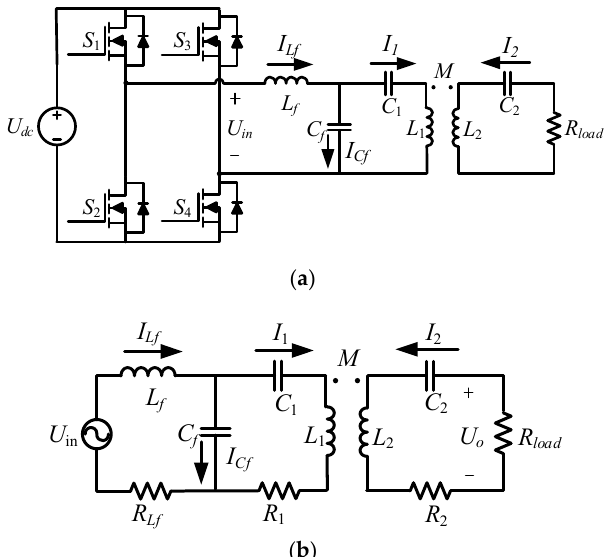
Figure 4. Wireless charging system with inductor–capacitor–capacitor and series (LCC-S) compensation. ( a ) Topology. ( b ) Equivalent circuit.